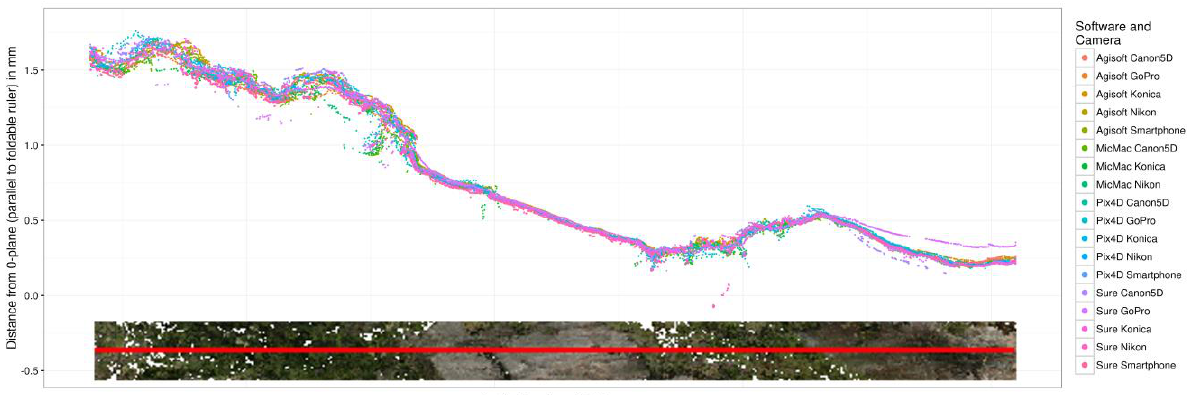
Figure 23. Scatter plot: Points along a horizontal profile for all dense point clouds resulting from all sensors and software packages. Below the scatter plot the profile (red) is presented on an exemplary point cloud covering vegetation and bare rock surfaces.